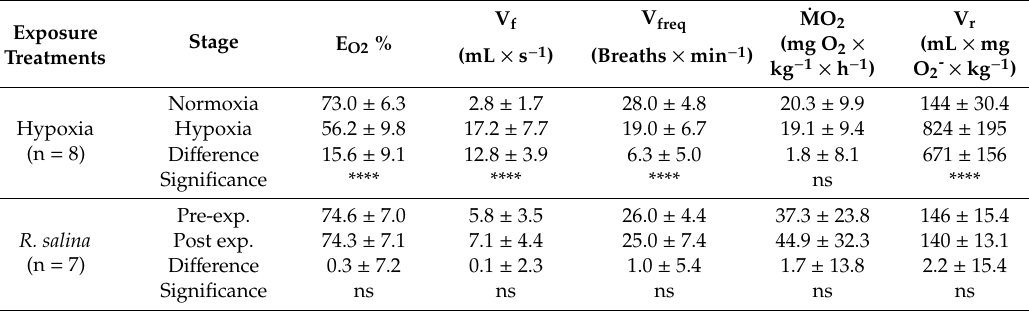
Table 1. Summary of respiratory parameters during the di ff erent stages of each exposure. Data from post exposure to P. parvum is divided into two groups, the entire experiment (post exp.) and the last 10 min. before the fish left the device. A comparison between severe hypoxia and the last 10 min. of exposure to P. parvum are added to the bottom of the table. All of the values are given as median ± standard deviation (SD) and significance levels are shown as asterisks (*) or non-significant (ns) ( p > 0.05 = ns, p ≤ 0.05 = *, p ≤ 0.01 = **, p ≤ 0.001 = *** and p ≤ 0.0001 =